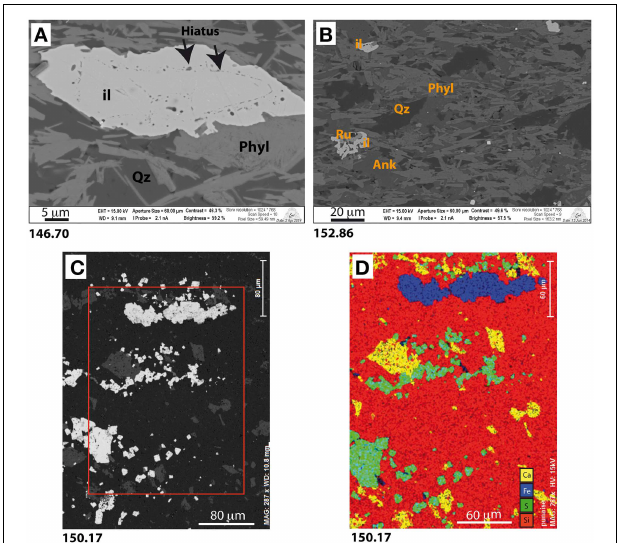
FIGURE 3 | SEM images and Si, S, Fe, Ca elements mapping of textures observed in sample (A) 146.70, (B) 152.86, and (C) 150.17; (D) mapping of the area delimited by the red rectangle in (C). Iron oxides and/or pyrites-rich alternating with quartz-rich layers are observed.